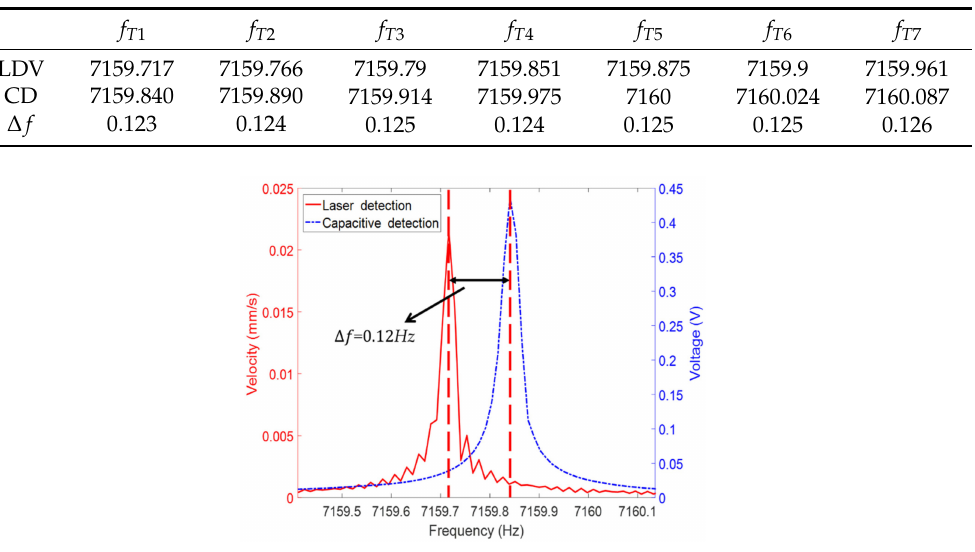
Figure 8. The resonant frequency measured by laser Doppler vibrometer (LDV; red) and capacitive detection (CD;